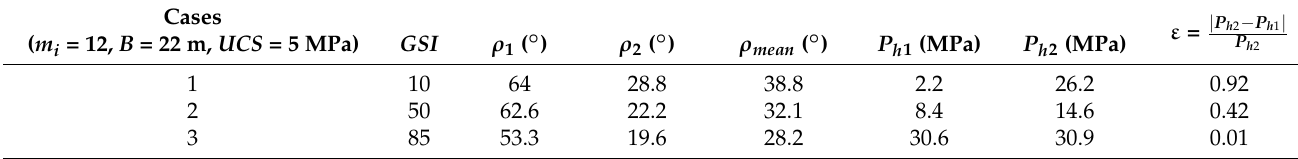
Table 5. Bearing capacity considering the self-weight of the material.